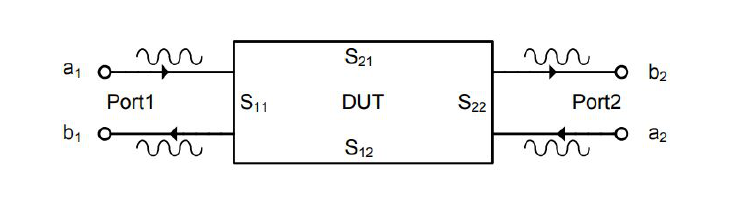
Figure 22. Basic concept of a Vector Network Analyzer.